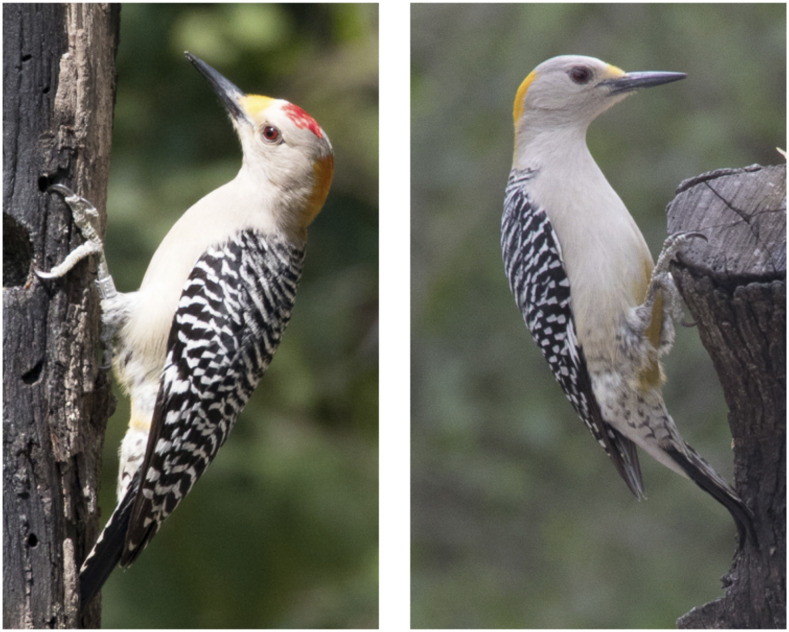
Male (left) and female (right) Golden-fronted Woodpecker (Melanerpes aurifrons). Photos by Bettina Arrigoni, cropped, and used under CC BY 2.0 license. Original photos available at: https://flickr.com/photos/69683857@N05/39849351035 and https://flickr.com/photos/69683857@N05/26752528708.